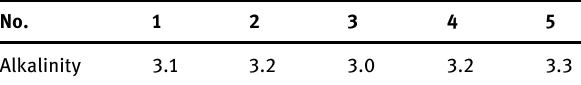
Table 15: Basicity of the converter slag - making agent products